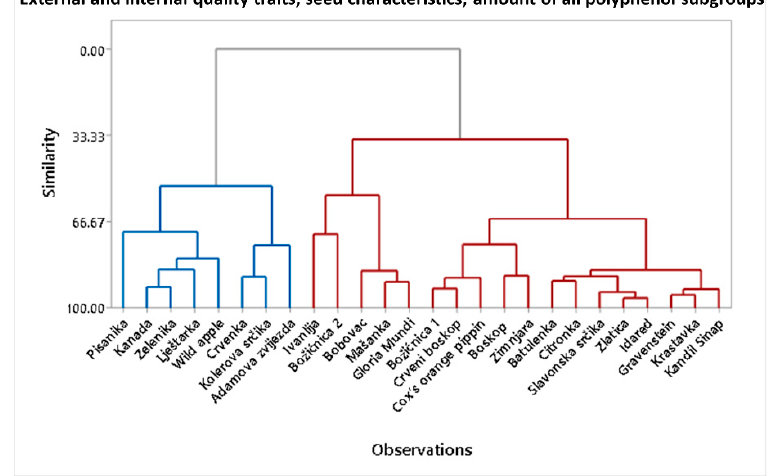
Figure 4. Dendogram of all fruit internal and external quality parameters, all seed parameters, and the amounts of all polyphenol subgroups in flesh and peel. It shows the clustering of apple varieties into two clusters (the group colored blue corresponds to higher polyphenol content and the group colored red corresponds to lower polyphenol content).